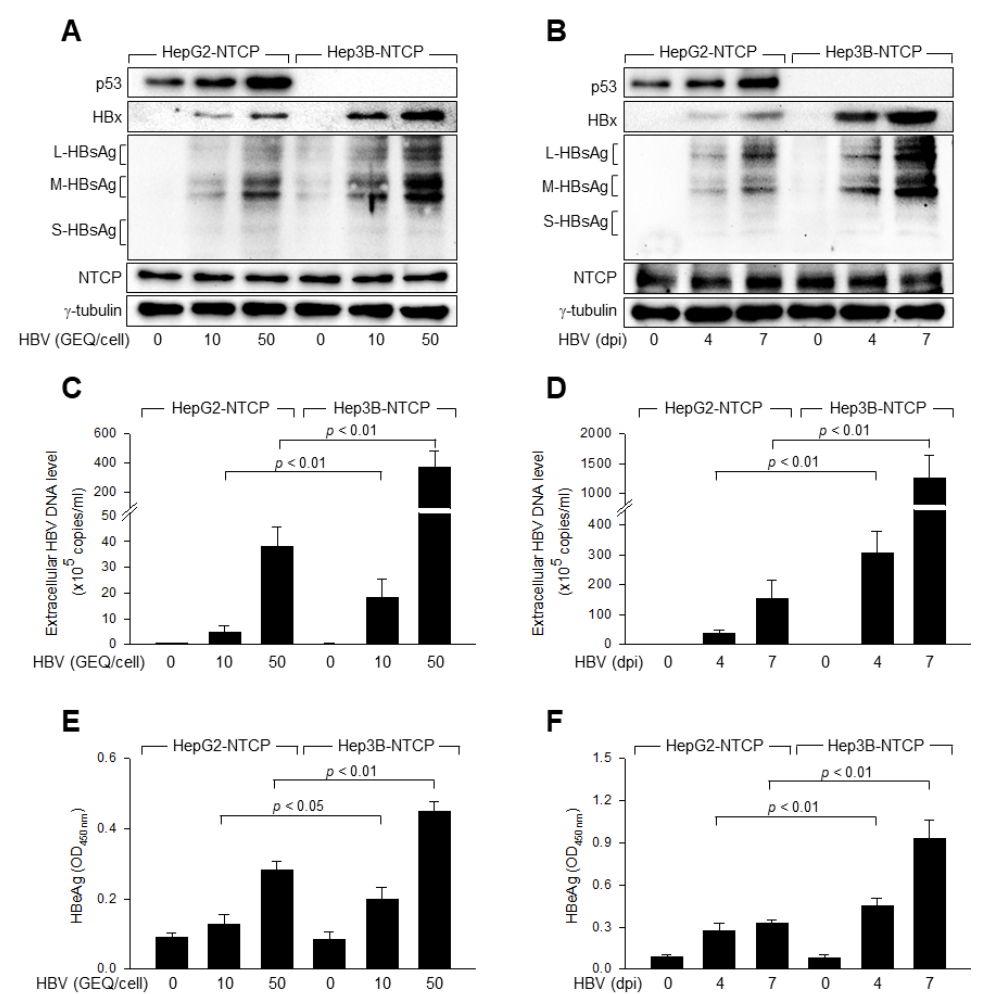
Figure 1. HBV replication is impaired in p53-positive human hepatoma cells. ( A ) HepG2-NTCP and Hep3B-NTCP cells were infected with HBV at the indicated genome equivalent (GEQ) per cell for 4 days. Levels of HBx and three HBV envelope proteins, large hepatitis B surface antigen (L-HBsAg), middle HBsAg (M-HBsAg), and small HBsAg (S-HBsAg) in cell lysates were measured by Western blotting. The levels of p53, Na + -taurocholate cotransporting polypeptide (NTCP), and γ -tubulin were also determined. ( B ) HepG2-NTCP and Hep3B-NTCP cells were infected with HBV at 50 GEQ/cell as in ( A ), followed by Western blotting at 0, 4, and 7 days post-infection (dpi). ( C ) Levels of HBV particles in cell supernatants prepared in ( A ) were determined by quantitative real-time PCR (qPCR) ( n = 7). ( D ) The levels of HBV particles in cell supernatants prepared in ( B ) were determined by qPCR ( n = 6). ( E ) The levels of HBeAg in cell supernatants prepared in ( A ) were measured by ELISA ( n = 4). ( F ) The levels of HBeAg in cell supernatants prepared in ( B ) were measured by ELISA ( n = 4).